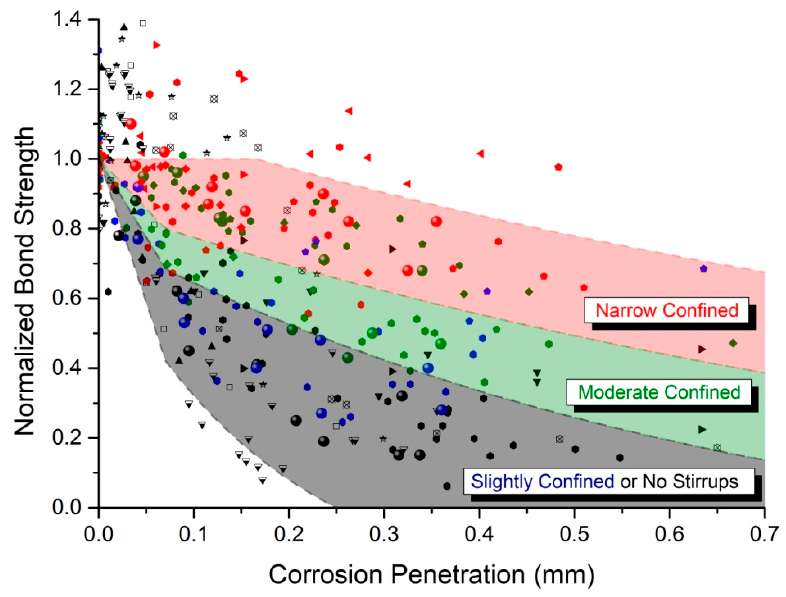
Figure 9. Proposed boundaries of bond loss depending on confinement level.